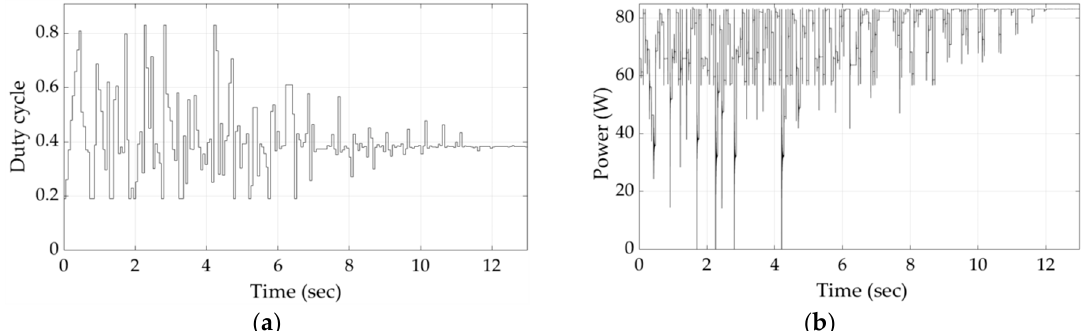
Figure 17. Results during execution of the PSO-based GMPPT process for shading pattern 1: ( a ) duty cycle versus time and ( b ) PV array output power versus time.